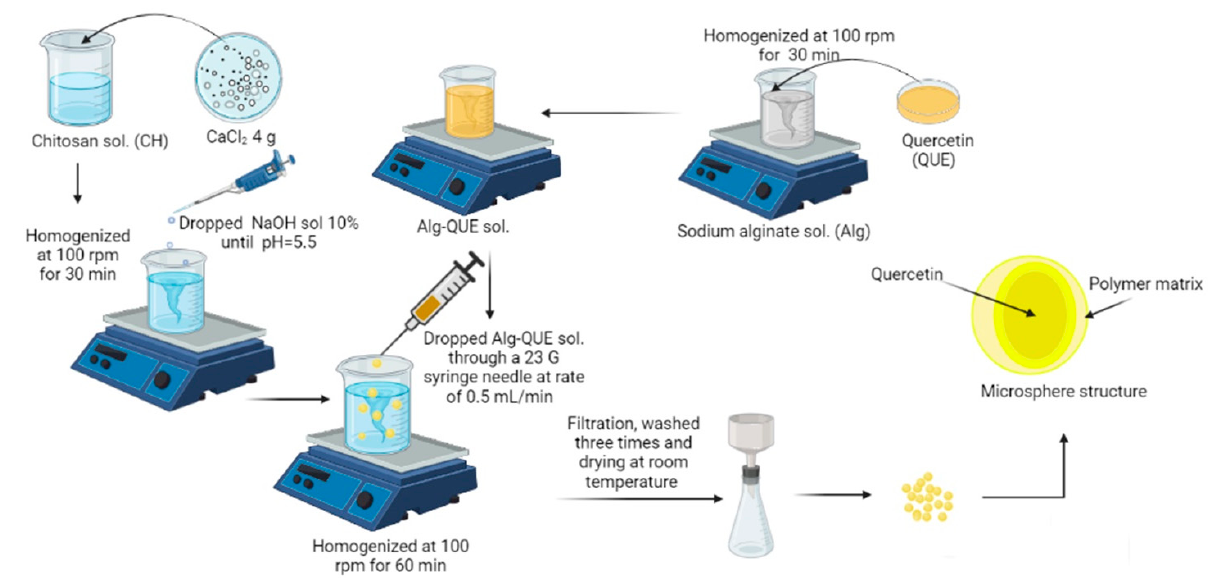
Figure 1. Preparation of quercetin microspheres by complex coacervation.